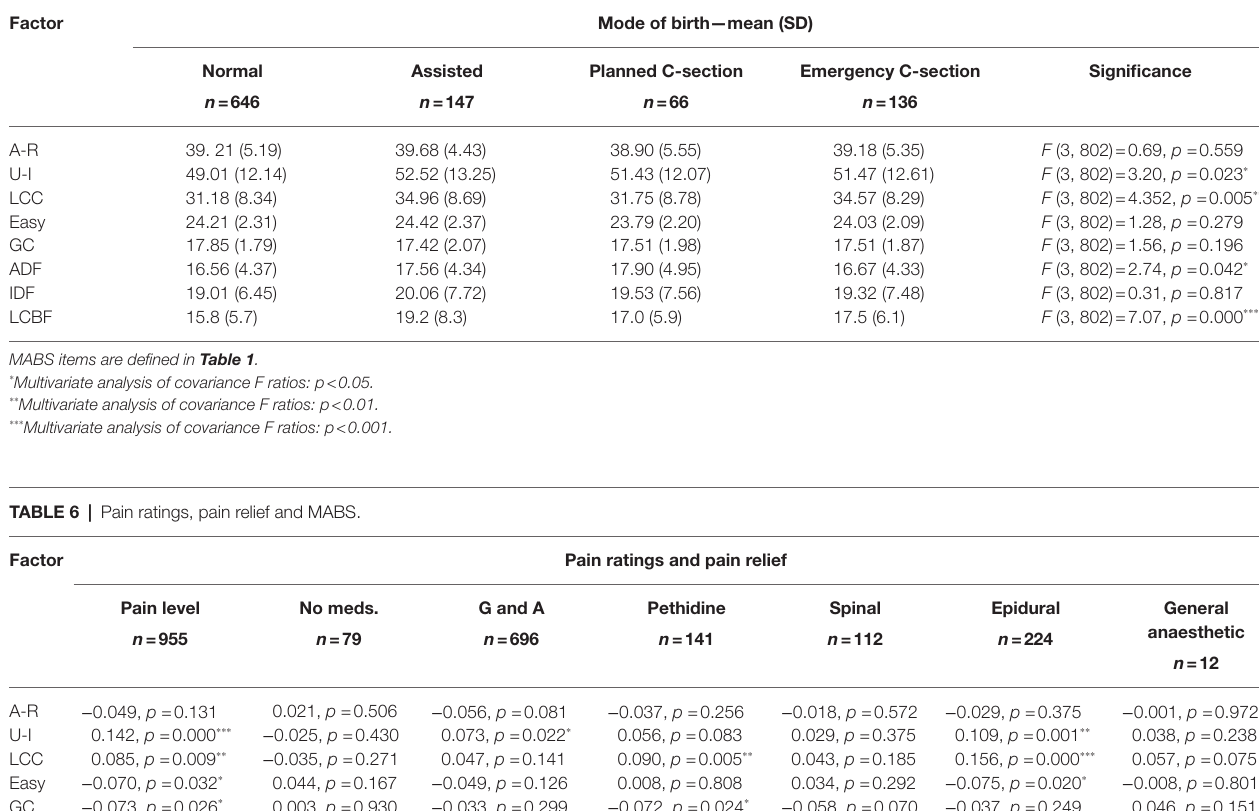
TABLE 5 | Birth mode and MABS.